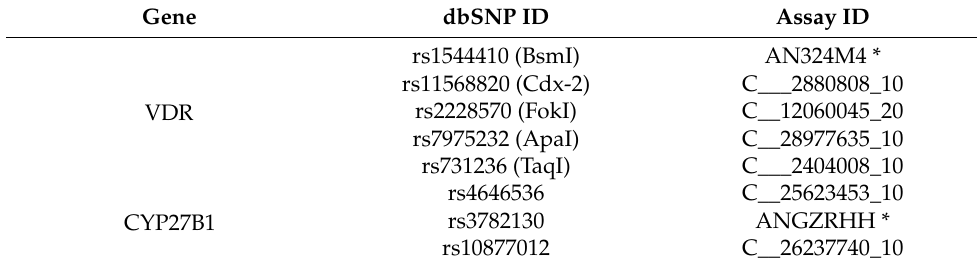
Table 1. Gene polymorphisms and TaqMan ®